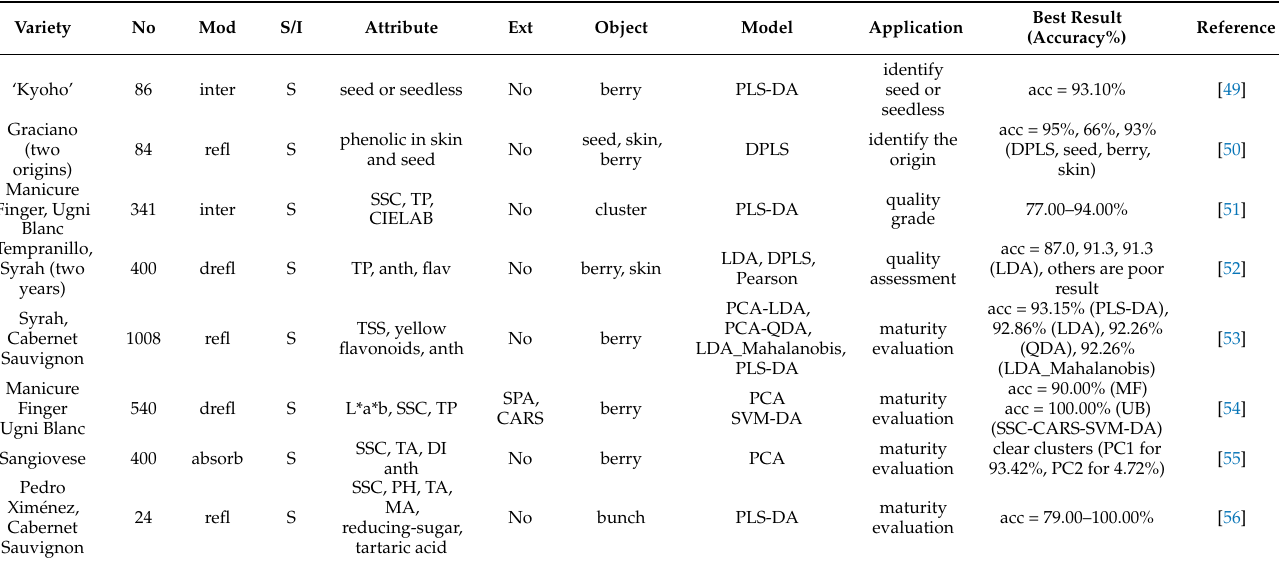
Table 2. Qualitative analysis of near-infrared spectroscopy (NIRS) in